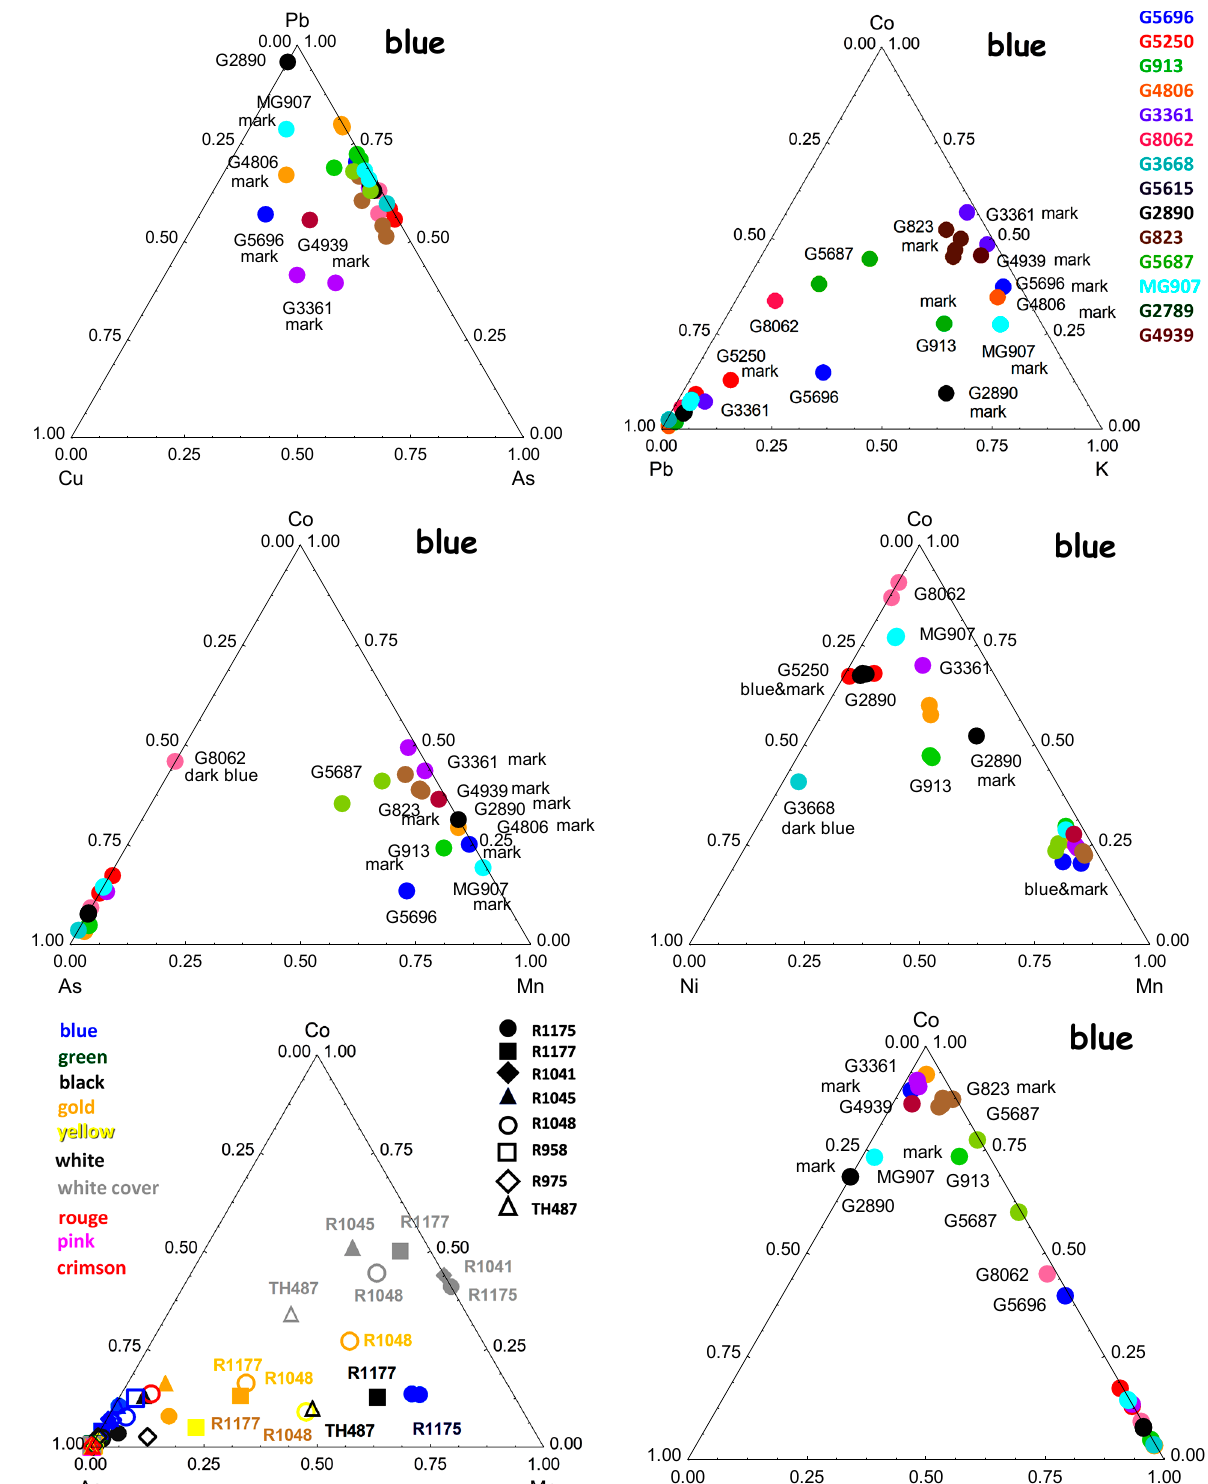
Figure 7. Comparison of the signal of elements associated with cobalt (Mn, Ni, U and As) for blue enamels ( top and center , Coll. mnaa-Guimet) and for all enamels ( bottom , Coll. Musée du Louvre). See legend to Figure 5 for explanation of symbols.